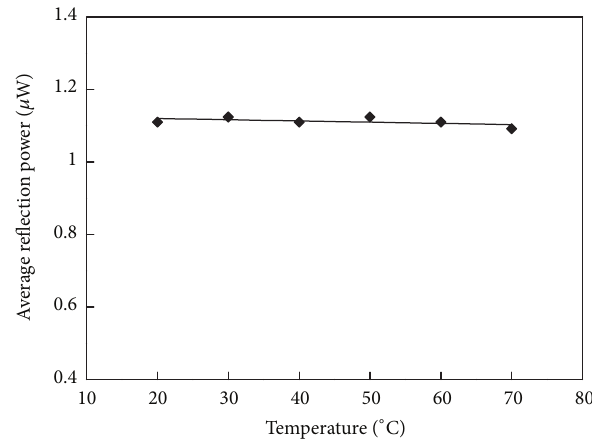
Figure 5: Temperature characteristic curve of the proposed vibra- tion